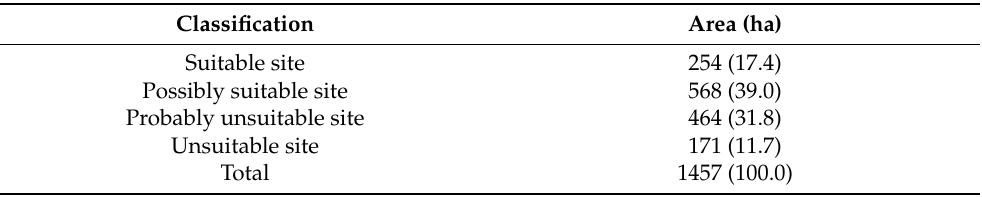
Values in parentheses indicate the percentage of total actual cultivation